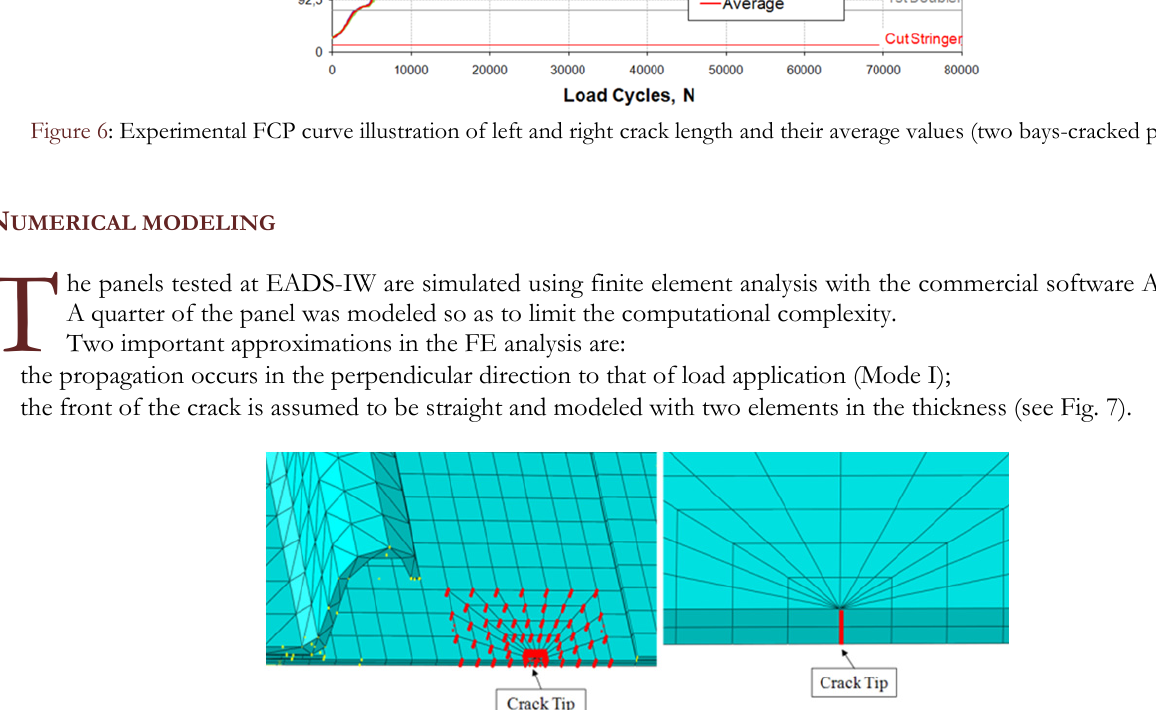
Figure 7: Straight crack front in the thickness